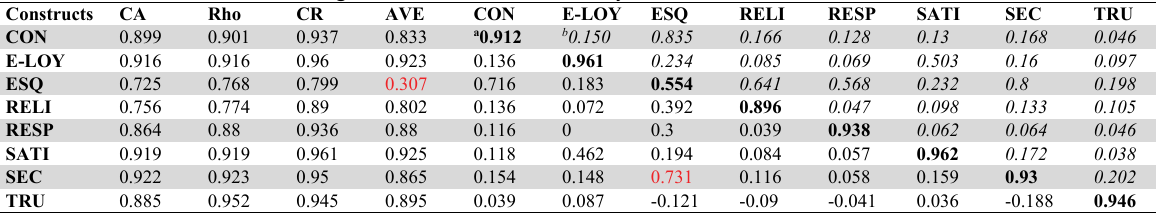
Inter-construct Correlations, Convergent and Discriminant Validity Constructs